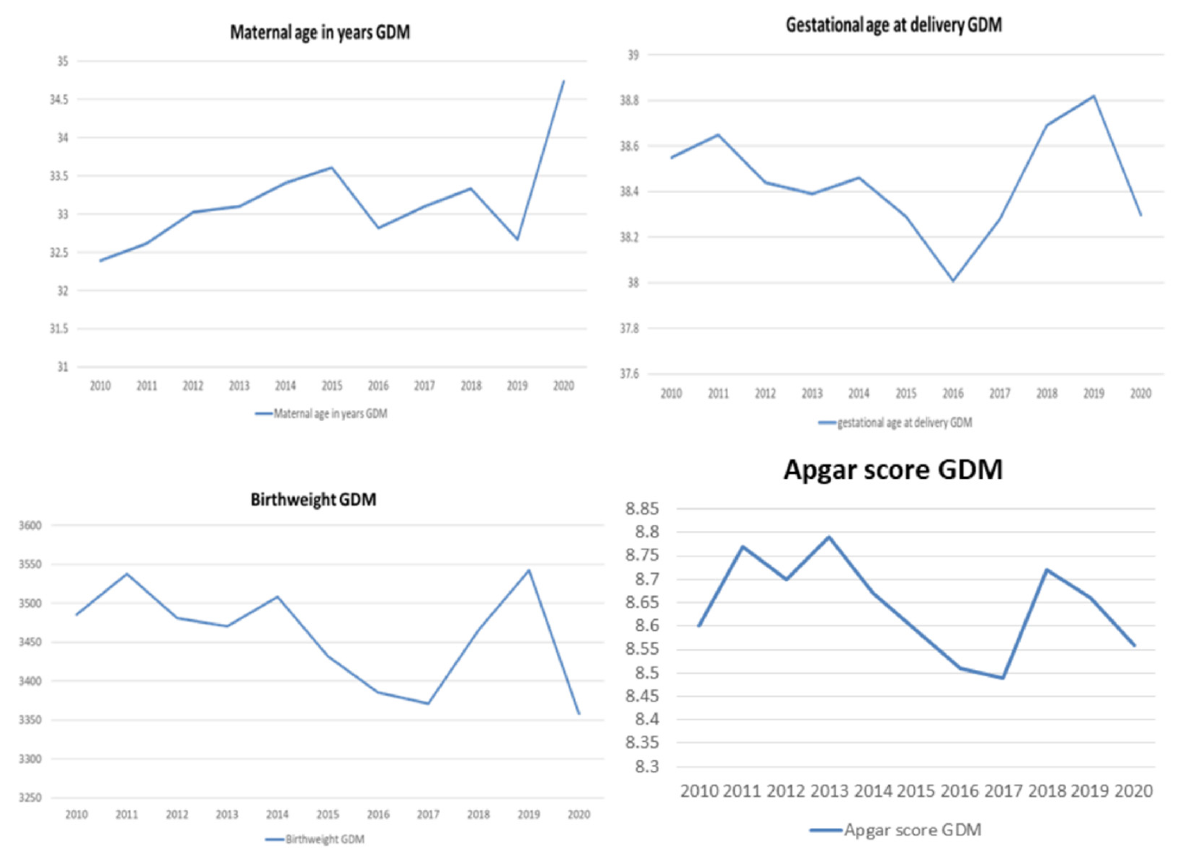
Figure 4. The trends in average maternal age, gestational age at delivery, newborns’ birth weight and average Apgar scores among women with GDM.